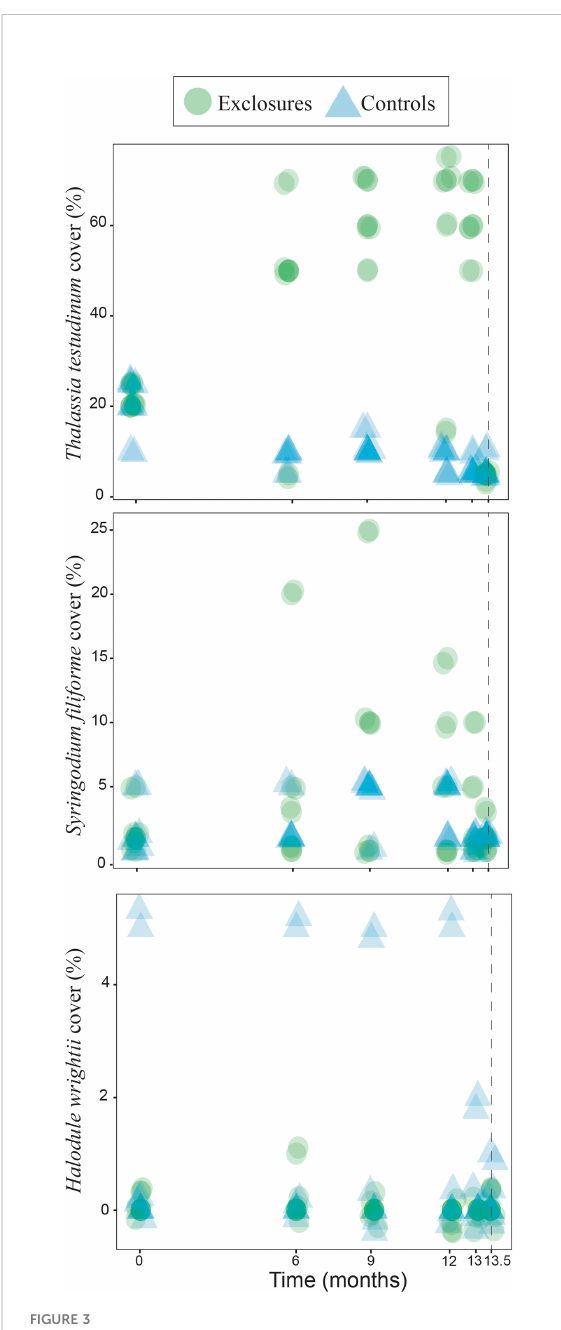
FIGURE 3 Seagrass cover per species within exclosures and in the control plots over 13 months of megaherbivore exclusion at Cahuita, southern Caribbean coast of Costa Rica. The dotted line marks a sampling two weeks after the removal of the exclosures. Results have been jittered for visualization purposes.